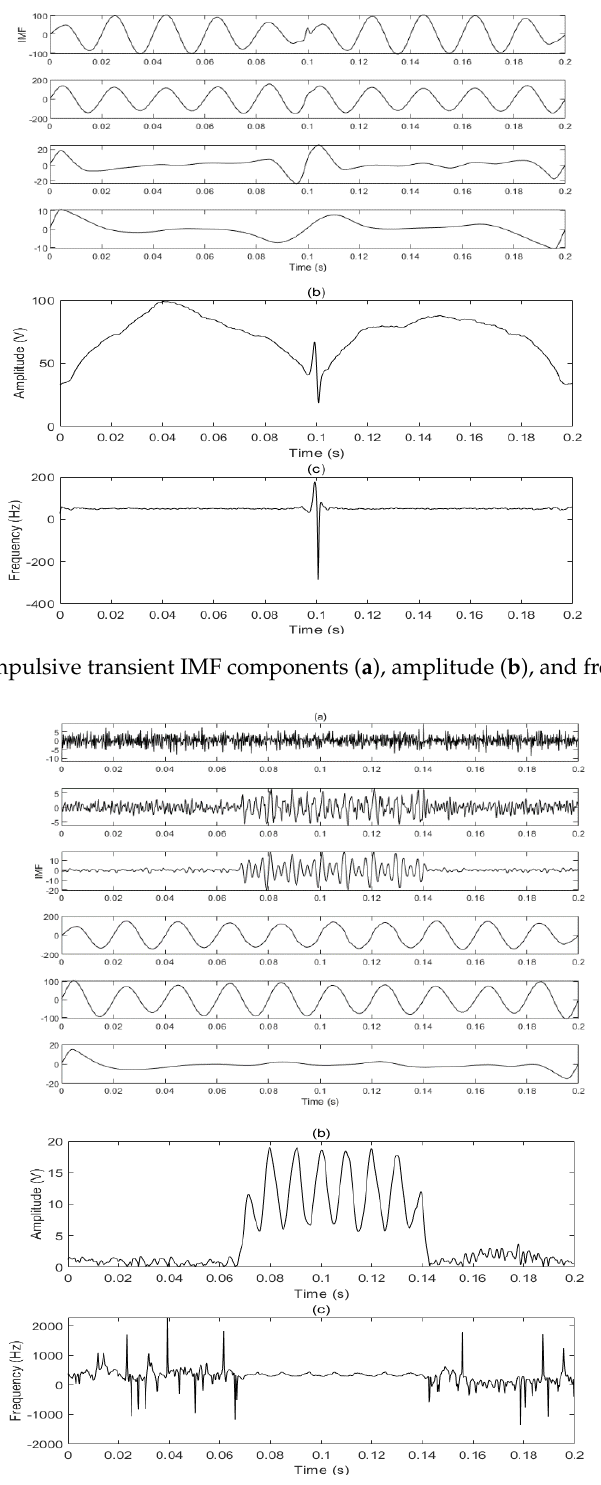
Figure 20. Harmonic IMF components ( a ), amplitude ( b ), and frequency ( c ).